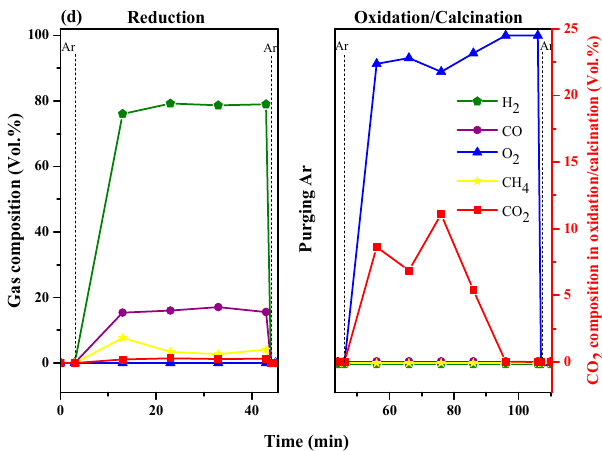
Figure 8. Variation of the gas composition with time for a typical cycle over: ( a ) Ca ‐ 9Co ‐ 18Y; ( b ) Ca ‐ 9Co ‐ 9Y; ( c ) Ca ‐ 9Co ‐ 4.5Y; and ( d ) Ca ‐ 9Co ‐ 3Y bifunctional catalyst/sorbents at 650 °C, S/C = 2.